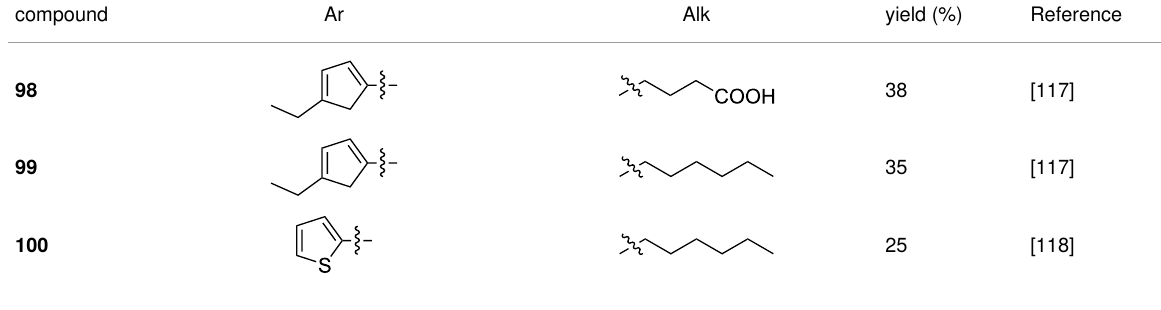
Table 1: [60]PCBM derivatives containing various aromatic and alkyl groups bound to the C 60 core.